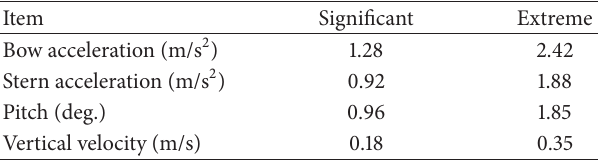
Table 4: Statistical results of motion